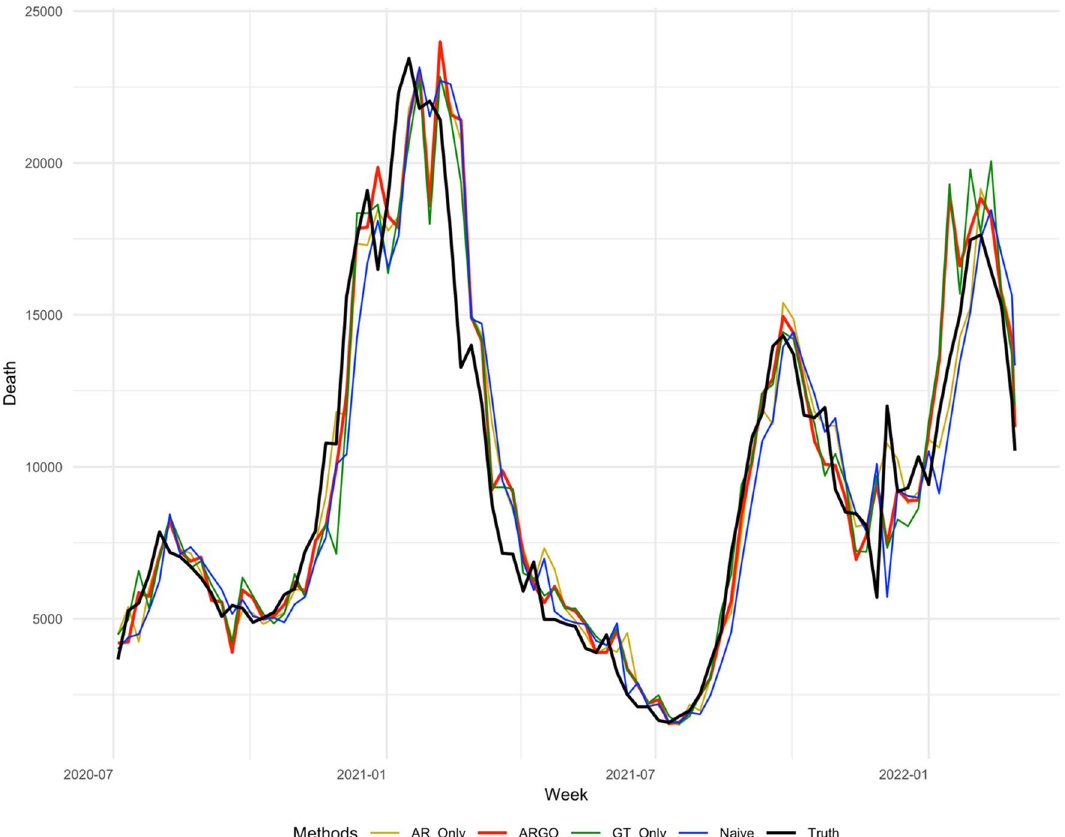
Figure 3. 1 week ahead national level COVID-19 weekly incremental death predictions’ comparisons weekly from 2020-07-04 to 2022-03-05. The method included are AR-Only, ARGO, GT-Only, Naive (persistence), truth. ARGO estimations (thick red), contrasting with the true COVID-19 death from JHU dataset (thick black) as well as the estimates from AR-Only (gold), GT-Only (Green), and Naive